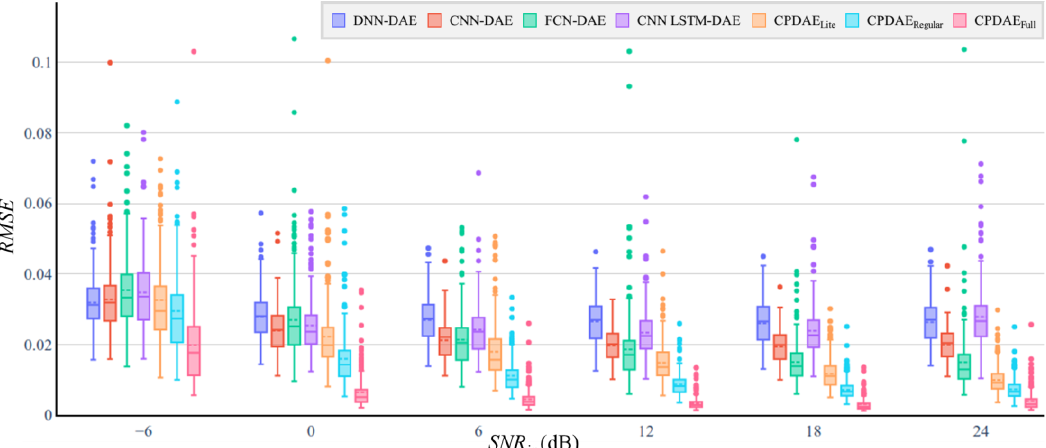
Figure 13. Box plots for RMSE comparison of the denoising criteria of all of the evaluated methods under six SNR in for the testing phase of NSTDB; the box plots include outliers (dot), minimum, interquartile range, median, maximum, and average (dotted line).